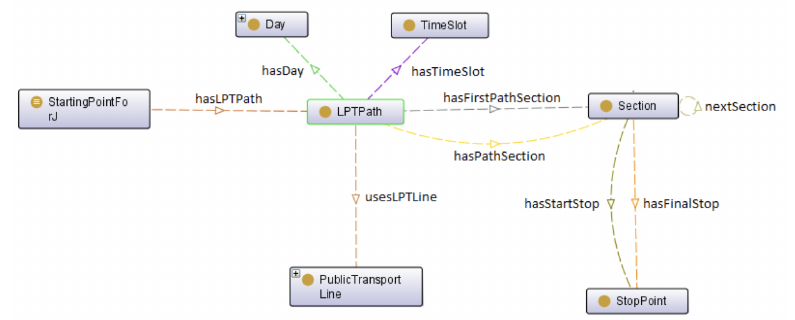
Figure 12. The main classes for representing a path of the Local Public